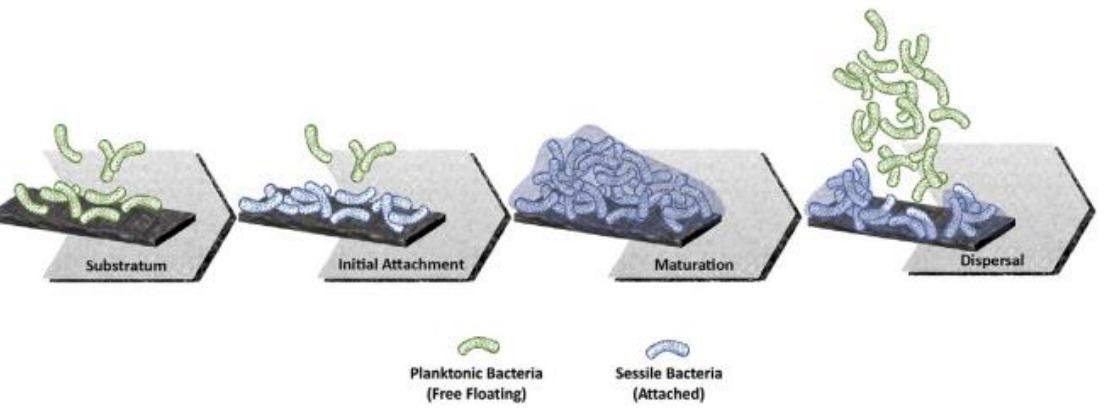
Figure 1. Schematic representation of the main stages of biofilm formation at the implant interface (From Ref. [32]).